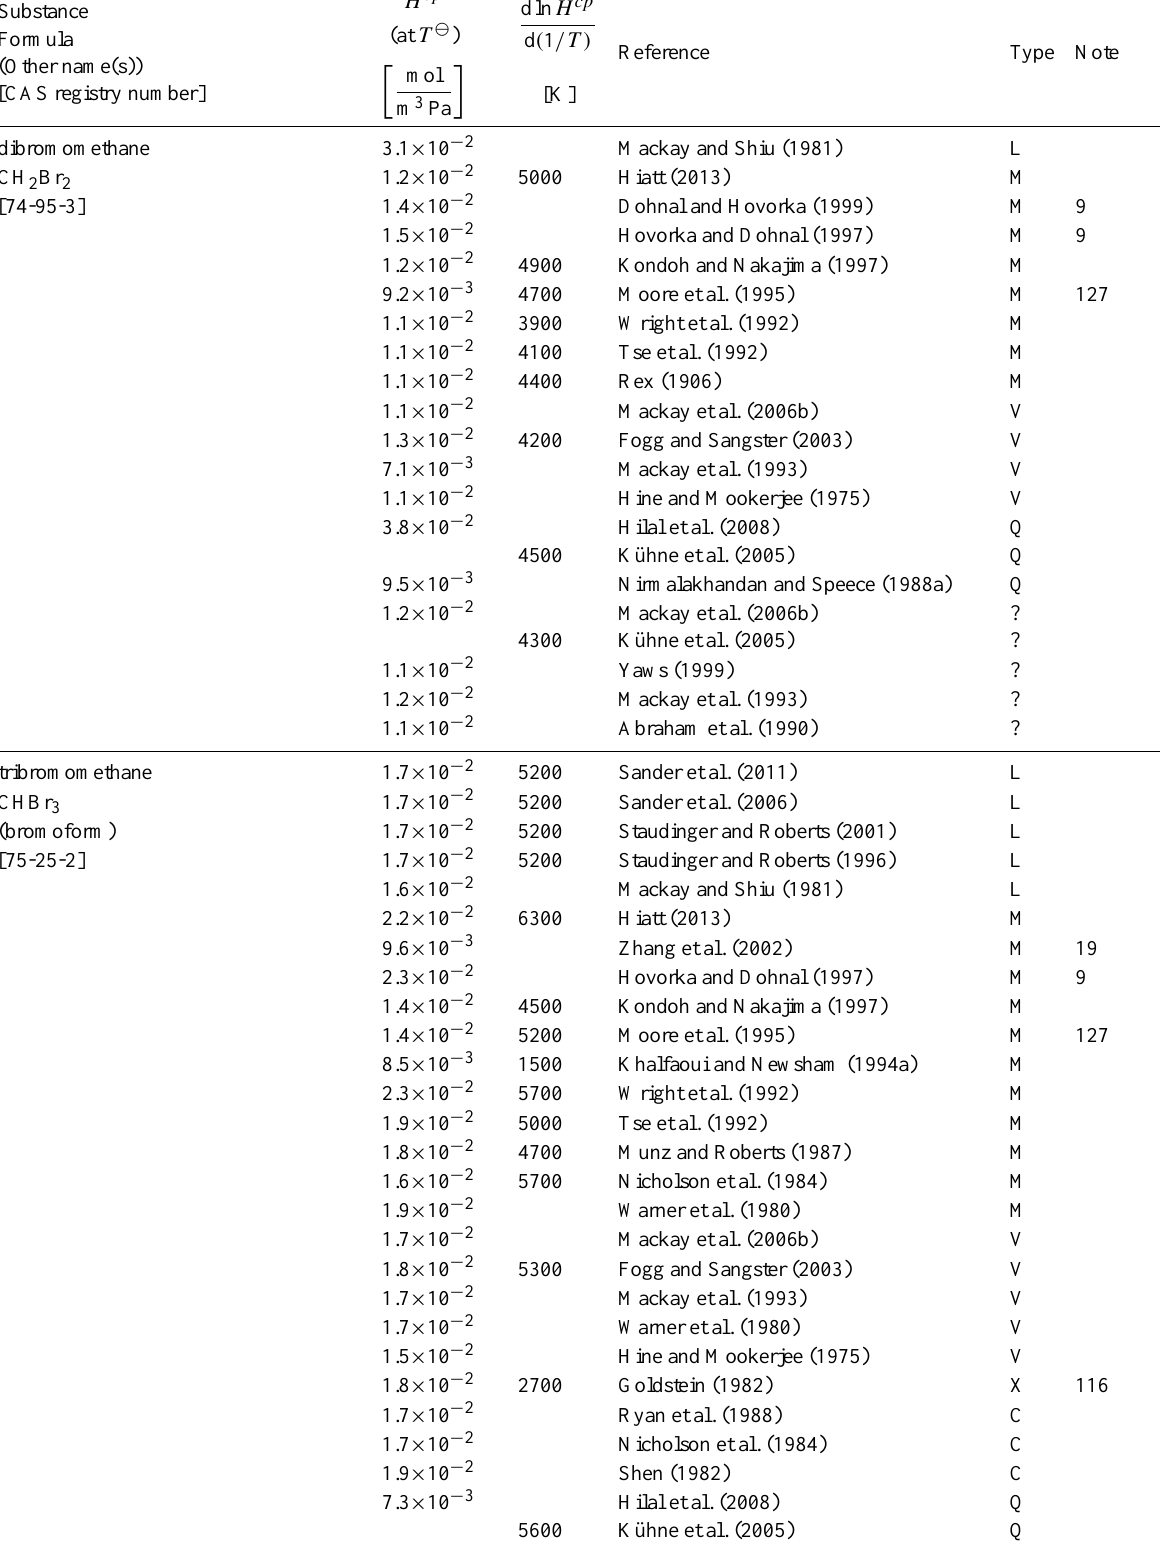
Table 6: Henry’s law constants for water as solvent